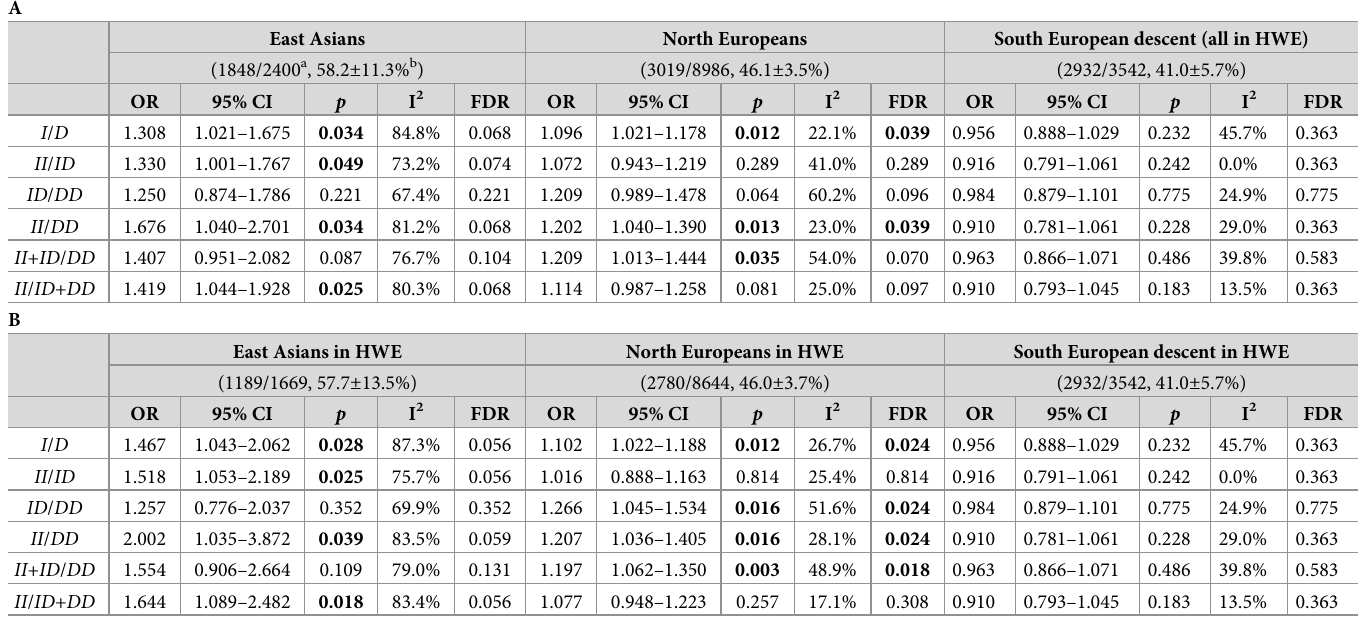
Table 4. Pooled odds ratios of rs1799752 I/D polymorphism and AD risk by ethnic